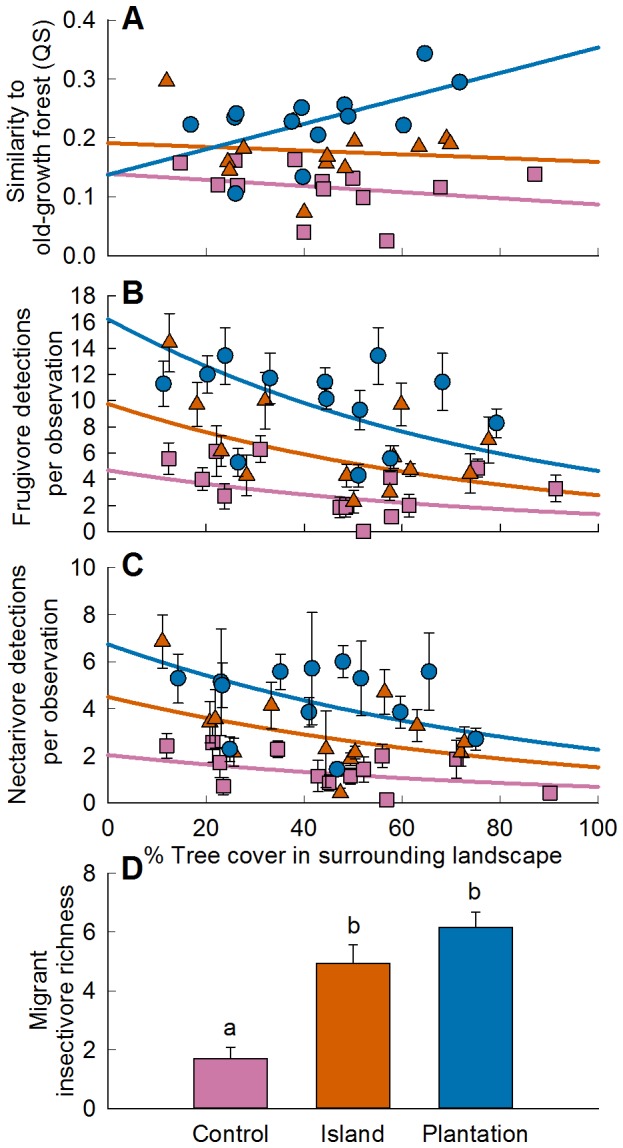
Compositional and functional attributes of bird communities predicted by restoration treatments and landscape tree cover.Error bars represent ±1 s.e.m. (A–C) Controls are represented by squares; islands by triangles, and plantations by circles. (A) Sørensen similarity of bird communities in restoration sites to bird communities in reference forest (550 m tree cover buffer); (B) frugivore abundance per observation (7 observations per point; 350 m buffer); (C) nectarivore abundance per observation (450 m buffer); (D) migrant insectivore richness (equal sampling intensity). Significance calculated using pairwise Wilcoxon rank sum tests with Bonferroni corrections (all P<0.004).